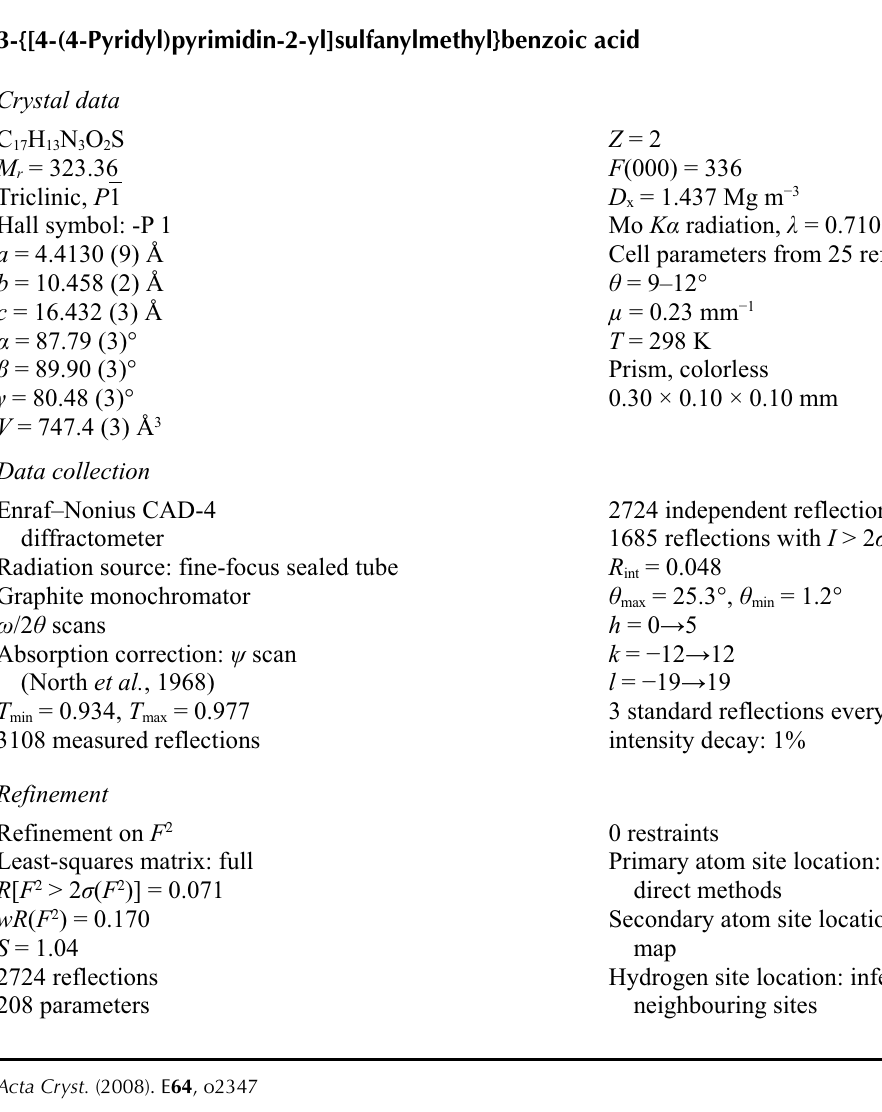
A section of the hydrogen bonded dimers viewed down the c axis. C—H··· π interactions are shown as dotted lines. Cg 3 denotes the phenyl ring centroid [symmetry code: x - 1, y , z